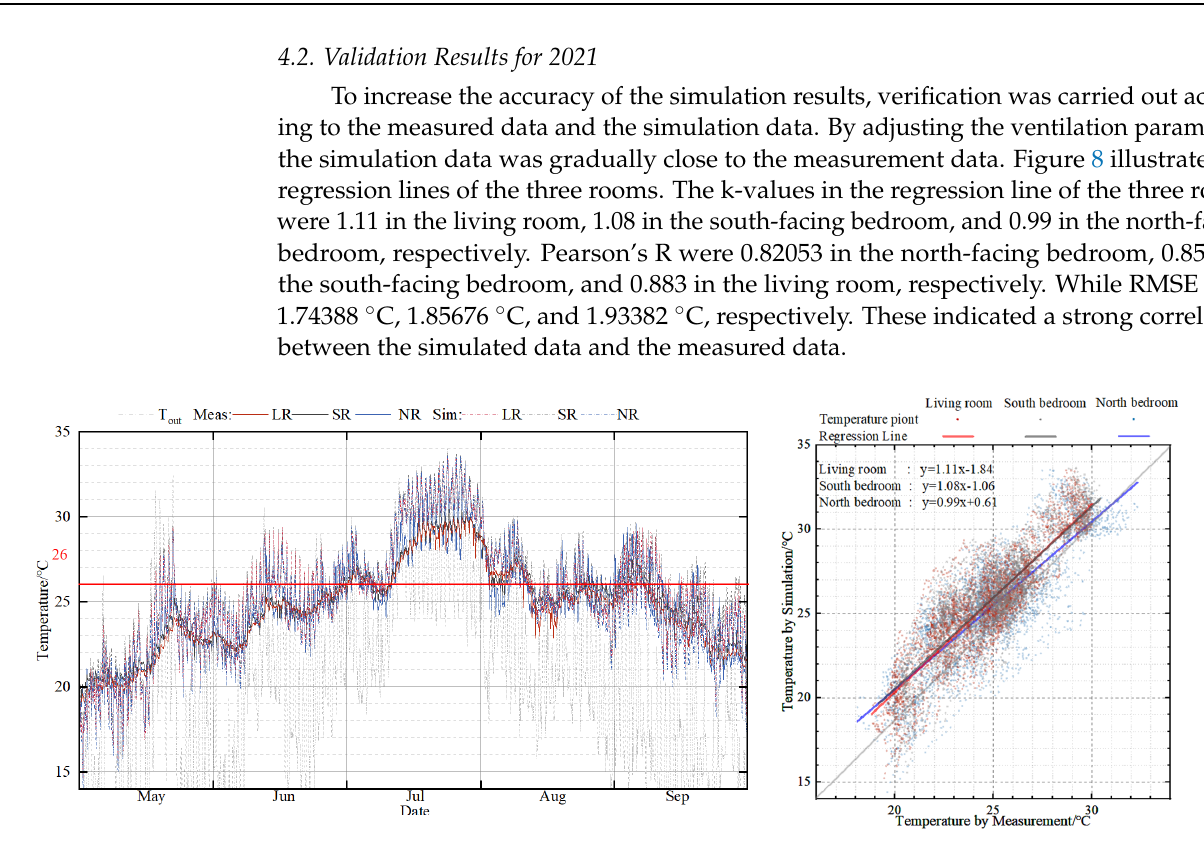
Figure 8. Validation data of three rooms in 2021.